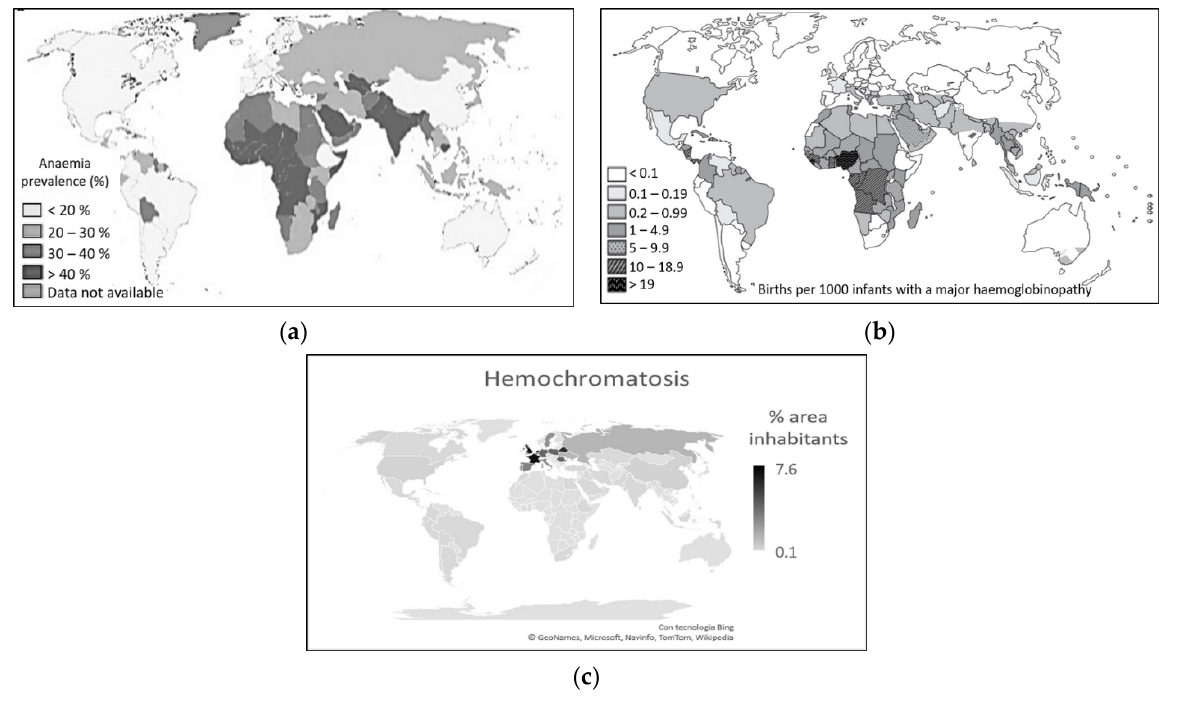
Figure 13. ( a ) Anemia distribution [42–44]. ( b ) Thalassemia distribution [45]. ( c ) Hemochromatosis distribution [23–27,42,46].